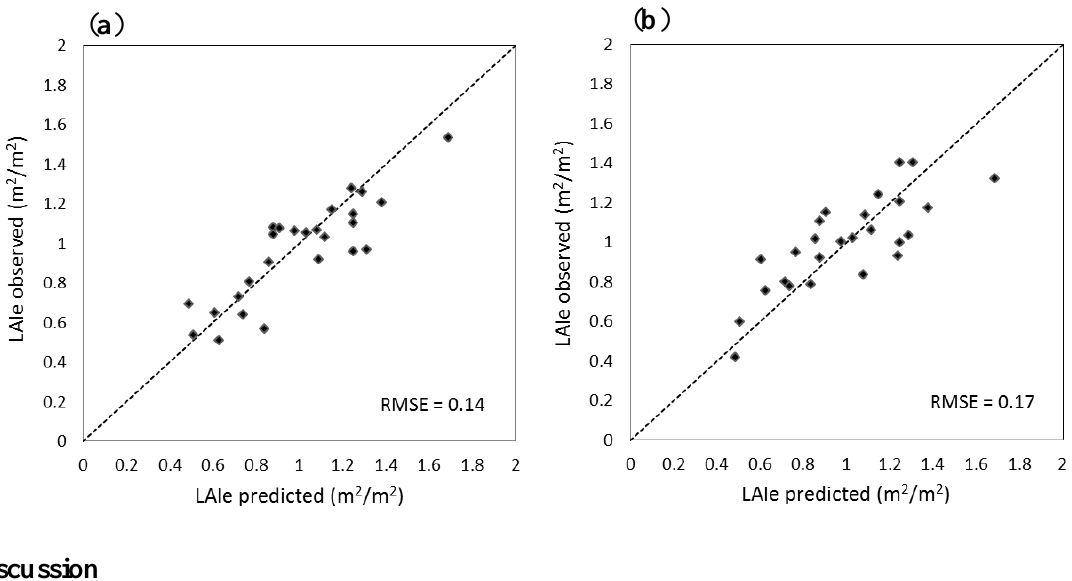
Figure 11. ( a ) Field-observed effective leaf area index (LAIe) versus ALS predicted LAI ( b ) Field-observed effective leaf area index (LAIe) versus DAI predicted LAI. Graphs show the regression function (solid lines) and 1:1 correspondence (dashed